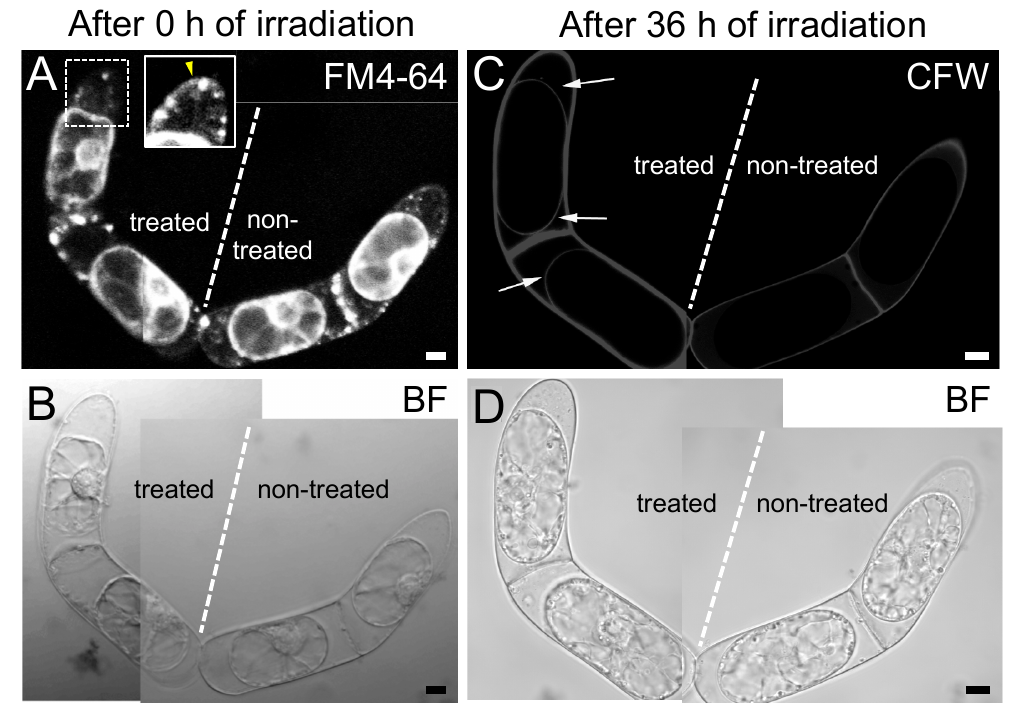
Figure 3. Cell wall regeneration in plasmolyzed BY-2 cells following the destruction of Hechtian strands. Of the four connected BY-2 cells examined, the two cells on the left were treated with femtosecond (fs) laser irradiation, while the two cells on the right were not treated with fs laser irradiation as a control. ( A , B ) the cells after 0 h of fs laser irradiation. Hechtian strands were labeled with FM4-64 ( A ). Inset in ( A ), the image before the irradiation, corresponding to the cell region marked by the square with dot line. The Hechtian strands were indicated by a yellow arrowhead. ( C , D ) the cells after 36 h of laser irradiation. Thin calcofluor white (CFW) signals were observed on the protoplast surface only in the two fs-irradiated cells (( C ) white arrows). The experiment was repeated two times, and the nine fs-irradiated cells showed similar levels of enhanced cell wall regeneration. Scale bars = 10 µm.